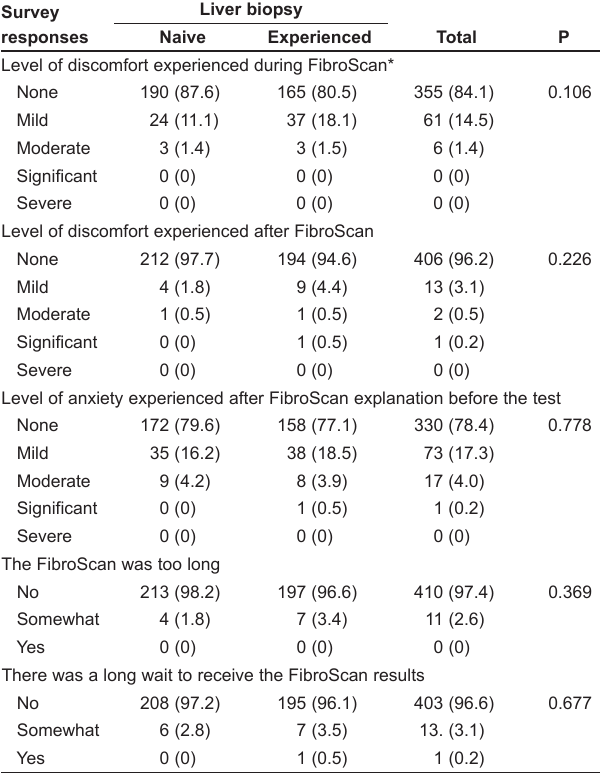
TABLE 2 Patient experience with transient elastography* versus liver biopsy FibroScan (n=422) Liver biopsy (n=205)